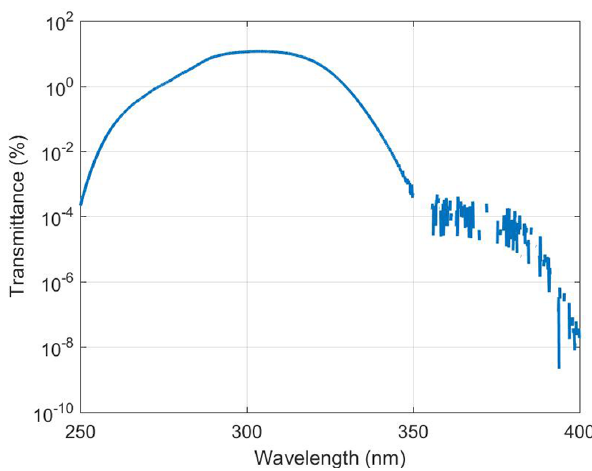
Figure 2. The transmission of a typical combined UG11-NiSO 4 fil- ter utilized by Brewer Mark IV to reduce the stray light measured with a Cary 5E spectrophotometer for Brewer no. 154